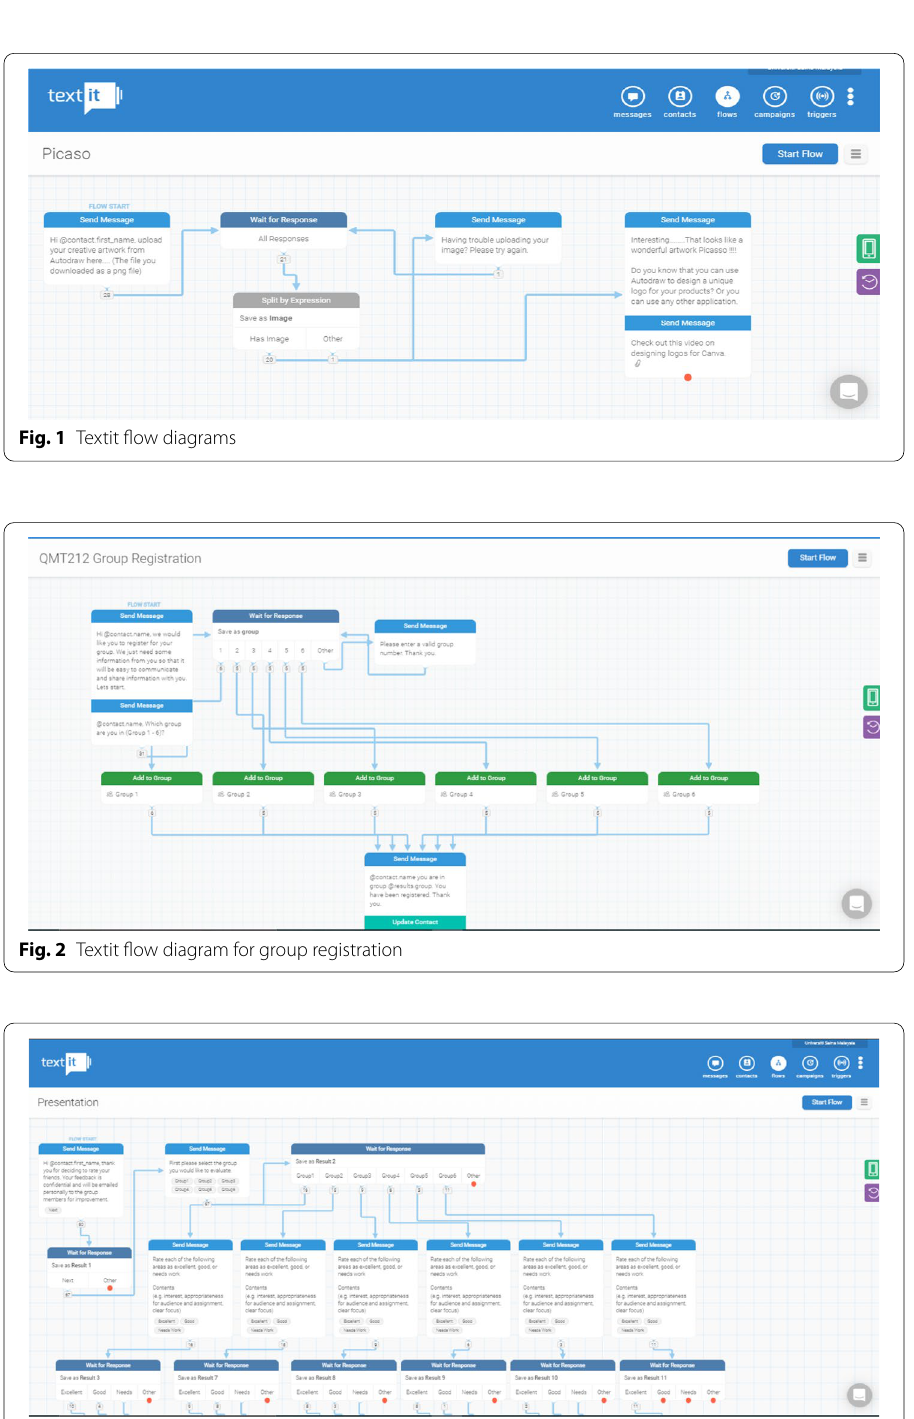
Fig. 3 Textit flow diagram for peer to peer